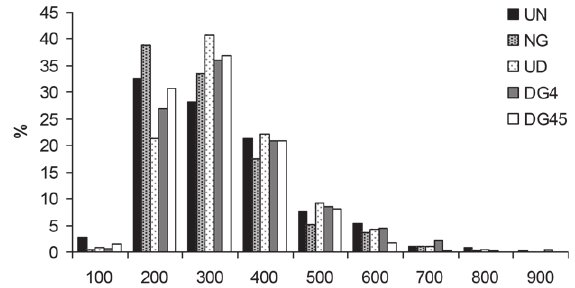
Figure 4 - Size distribution of myosin-V stained myenteric neurons. They were classified in classes of 100 µ m 2 for the animals in the groups: untreated normoglycaemic (UN), glutamine-treated normoglycaemic (NG), untreated diabetic (UD), glutamine-treated diabetic (DG4), glutamine-treated diabetic (dG45). n = 5 rats per group.